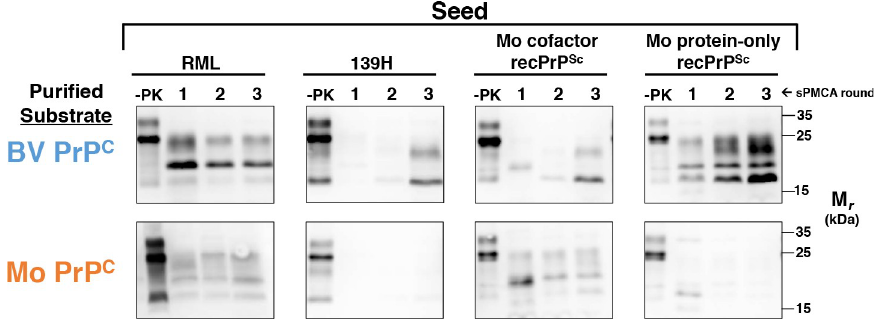
Fig 2. Susceptibility of BV PrP C and Mo PrP C substrates in reconstituted sPMCA. Western blots showing three- round reconstituted sPMCA reactions using either BV or Mo partially purified PrP C substrates supplemented with PrP 0/0 BH and seeded with various seeds, as indicated. -PK = samples not subjected to proteinase K digestion; all other samples were